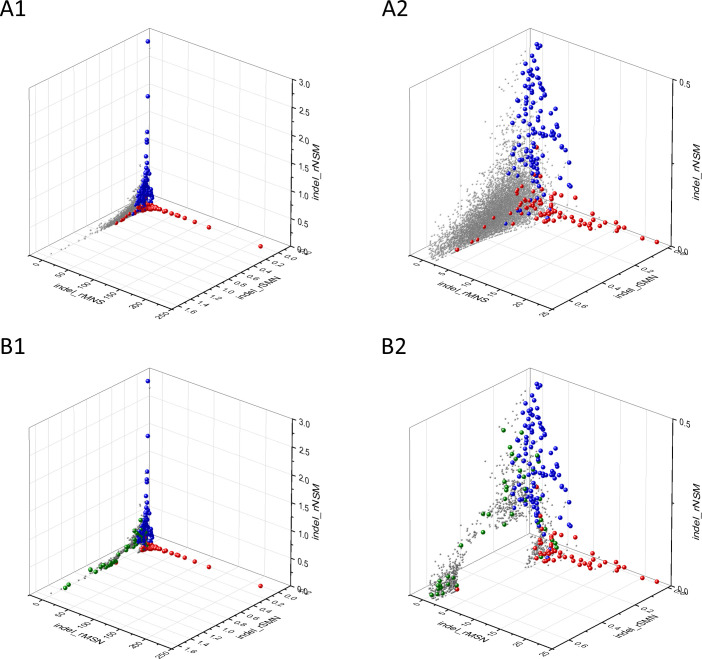
Analyses of indel_rSMN, indel_rMSN and indel_rNSM parameters of human protein-coding genes of tumor tissues.The figure shows the results of the analysis of 13930 transcripts containing at least 100 subtle, confirmed somatic mutations from tumor tissues. Axes x, y, and z represent paramerters indel_rSMN, indel_rMSN and indel_rNSM defined as the ratio of indel_fS/(indel_fM+indel_fN), indel_fM/(indel_fS+indel_fN) and indel_fN/(indel_fS+indel_fM), respectively. Each ball represents a human transcript; the positions of transcripts of the genes defined by Vogelstein et al., 2013 as oncogenes (OGs, red balls) or tumor suppressor genes (TSGs, blue balls) are highlighted. Panels A1 and A2 show the distribution of the 13,930 transcripts at different magnification. Note that the majority of human genes are present in a dense cluster but known OGs and TSGs separate significantly from the central cluster and from each other. The indel_rNSM values of TSGs are higher, their indel_rMSN and indel_rSMN are lower than those of passenger genes. OGs also separate from passenger genes in that their indel_rMSN values are higher and their indel_rSMN values are lower than those of passenger genes. Panels B1,B2 show data at different magnification only for candidate cancer genes present in the CG_SO2SD_SSI2SD list (see Supplementary file 31). The positions of transcripts of the genes identified by Vogelstein et al., 2013 as OGs (large red balls) or TSGs (large blue balls) are highlighted. The positions of novel cancer gene transcripts validated in the present work are highlighted as large green balls.